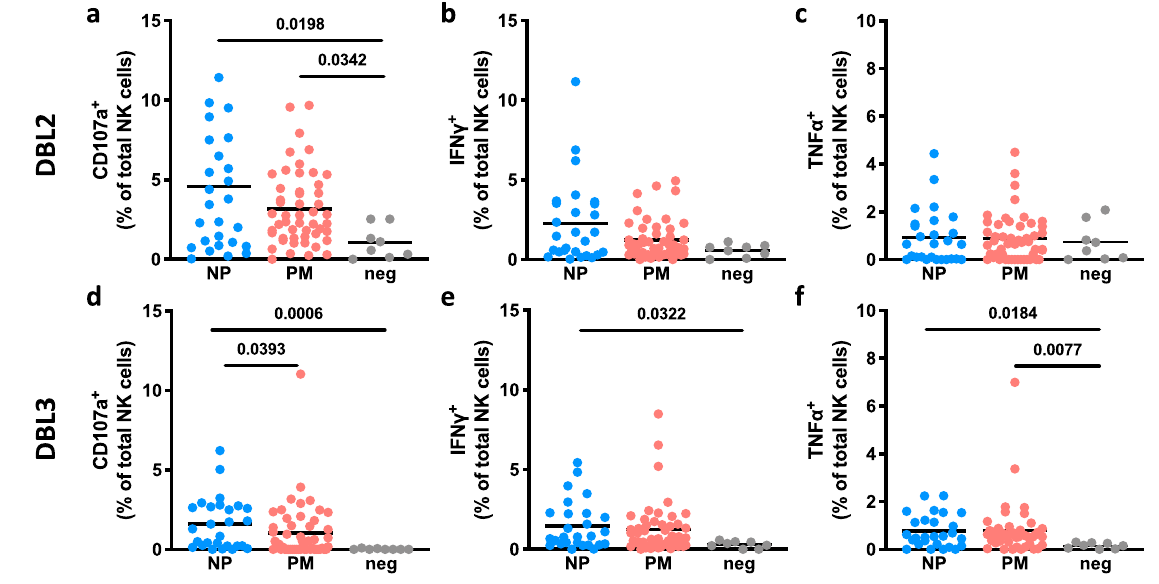
Figure 3. Human NK cells lack activation in presence of DBL2- or DBL3-specific Abs from pregnant women with malaria. NK cells were assessed for surface CD107a expression and intracellular IFNγ and TNFα production in the presence of VAR2CSA subdomains DBL2 ( a – c ) or DBL3 ( d – f ). Percentage of activation markers expressed by NK cells (mean of three separate donors) are shown. NK cells were stimulated with purified IgG Abs from pregnant women mid pregnancy with placental malaria (PM; N = 50; red) or from pregnant women with non-placental malaria (NP; N = 27; blue) at delivery in the presence of VAR2CSA subdomains DBL2 or DBL3. IgG Abs from malaria-naïve donors were used as negative control (N = 8; grey). Activation marker expression of NK cells incubated without Abs and median of SIV gp120-specific responses were subtracted as background. Statistical comparison between groups was performed using a Kruskal–Wallis test corrected for multiple comparisons using Dunn’s multiple comparison method (p-values are shown on